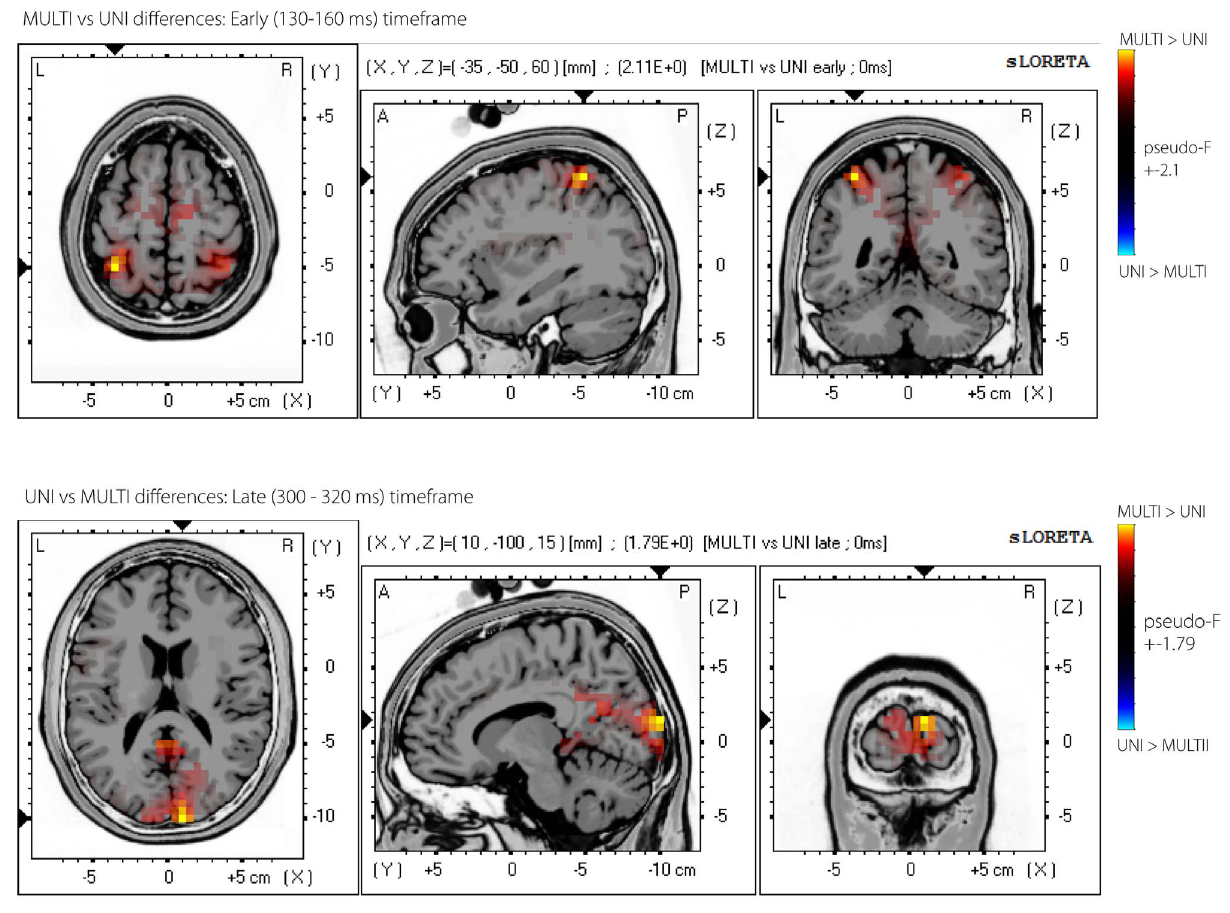
Figure 7. sLORETA source localisation. sLORETA statistical image showing significant pseudo-F values from a voxel-wise random permutation test between MULTI and UNI sLORETA source localisations in the early (130–160 ms) and late (300–320 ms) timeframes. The pseudo F-statistics for voxels with significant differences were plotted in their appropriate locations in Talairach space on the MNI Colin-27 T2 template brain.